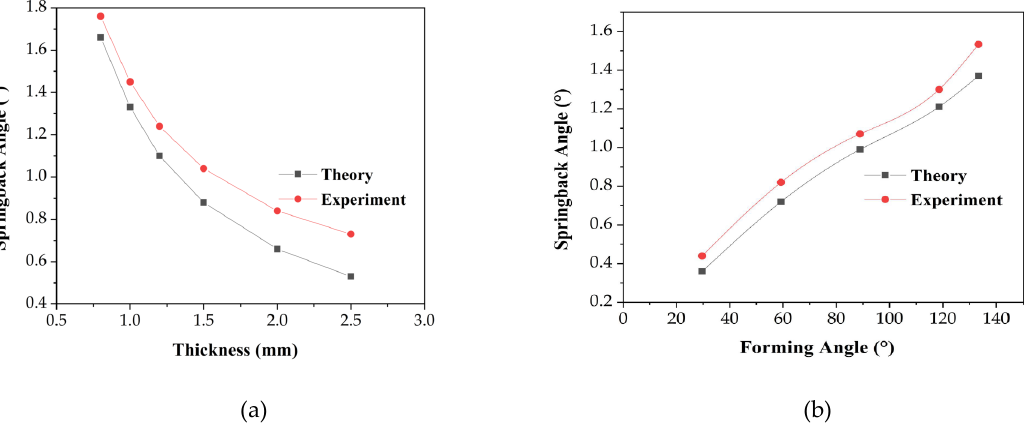
Figure 14. E ff ects of thickness and forming angle on springback control: ( a ) E ff ect of plate thickness. Figure 14. Effects of thickness and forming angle on springback control: ( a ) Effect of plate thickness. ( b ) E ff ect of forming ( b ) Effect of forming angle.